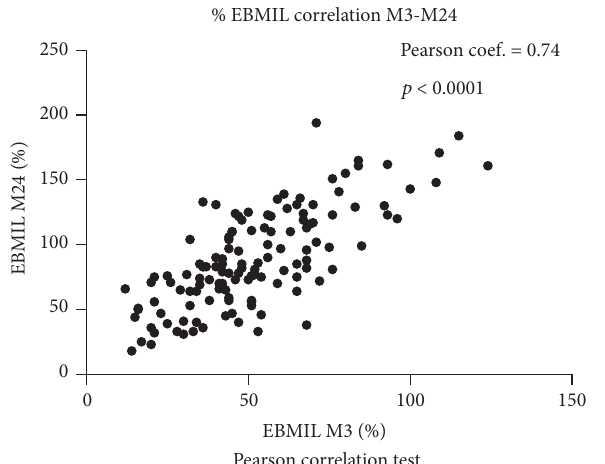
Figure 2: Excess Body Mass Index Loss (% EBMIL) correlation test between M3 and M24. EBMIL: Excess BMI Loss; M3: at 3 months; M24: at 24 months.